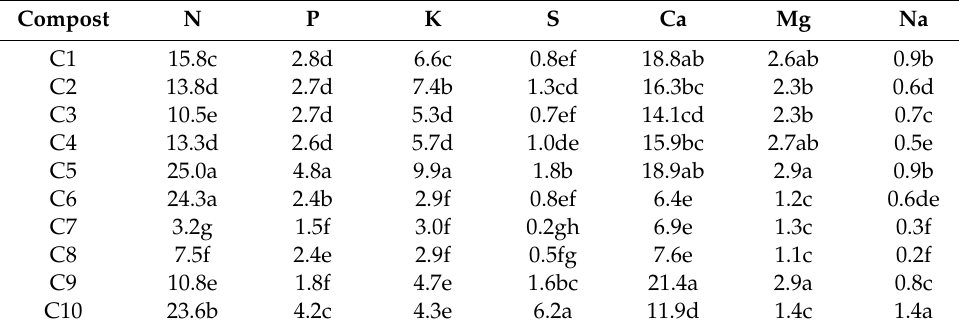
Table 3. Macronutrient contents in analysed composts (g · kg − 1 ).